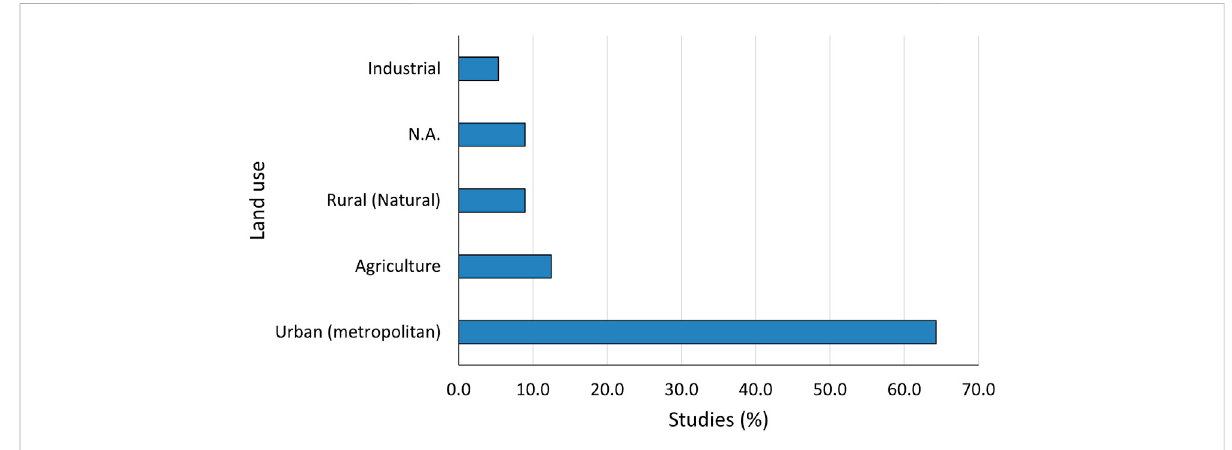
FIGURE 9 Land use metadata occurring in studies (%) on macroplastics in rivers. N.A. (not assessed) indicated that the data were not reported for the speci fi c study.